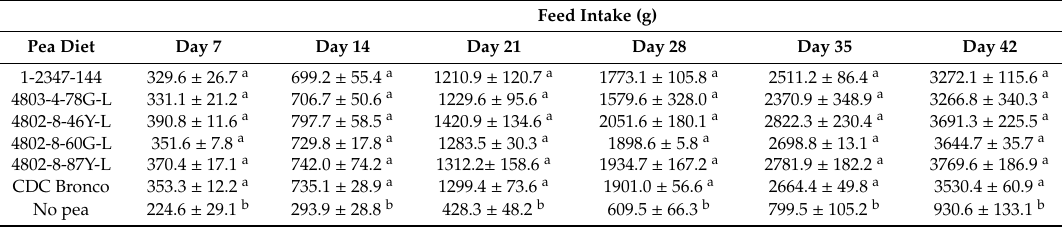
Table 4. Experimental cumulative feed intake 1